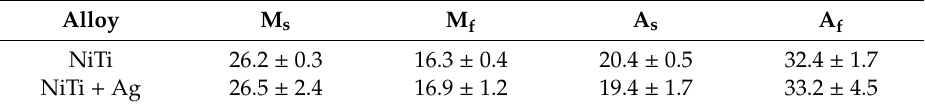
Table 2. Singular temperatures (°C) for the Ni-Ti and NiTi with silver nanoparticles